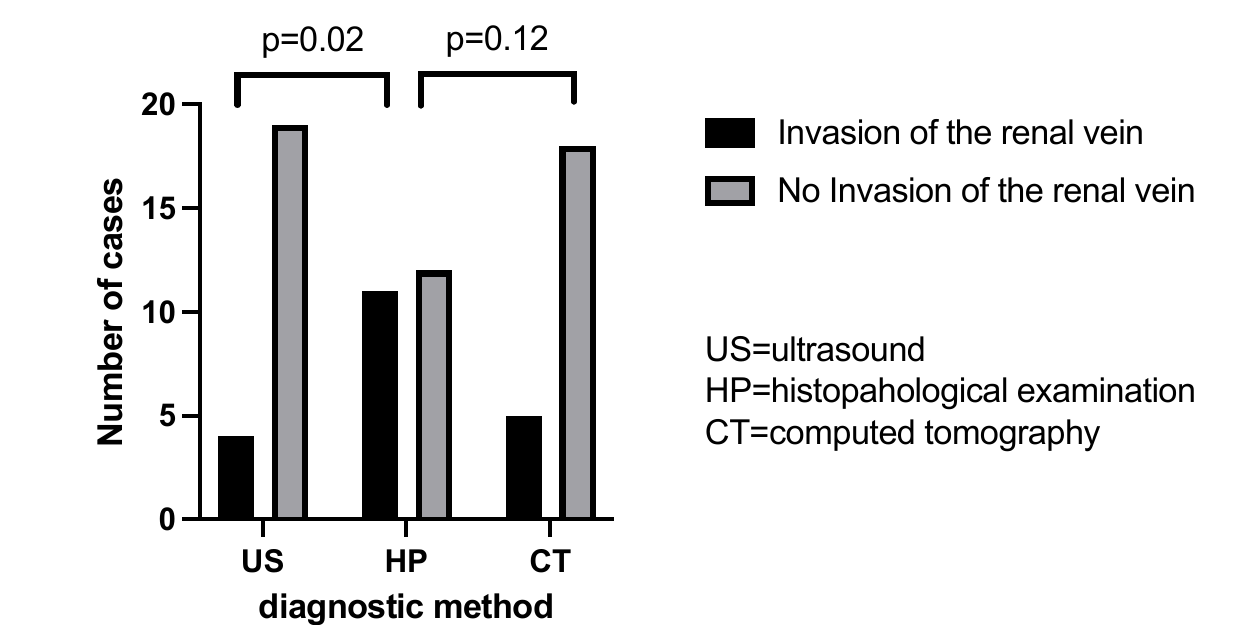
Table 2. Chi square analysis (US = ultrasound, TC = computed tomography, IO = intraoperatively).